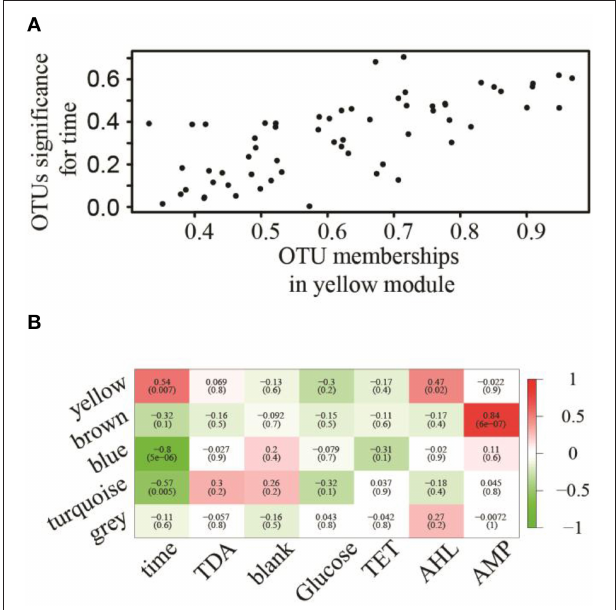
FIGURE 2 | Association of modules with external treatment factors. (A) OTUs associated with treatment–time with respect to their membership significance belonging to the yellow module. (B) Eigengene adjacencies heatmap identifying modules (row) that significantly associated with chemical treatments (column). Negative correlations (green) and positive correlations (red) indicate high adjacency (DiLeo et al., 2011), while white (zero) indicates low